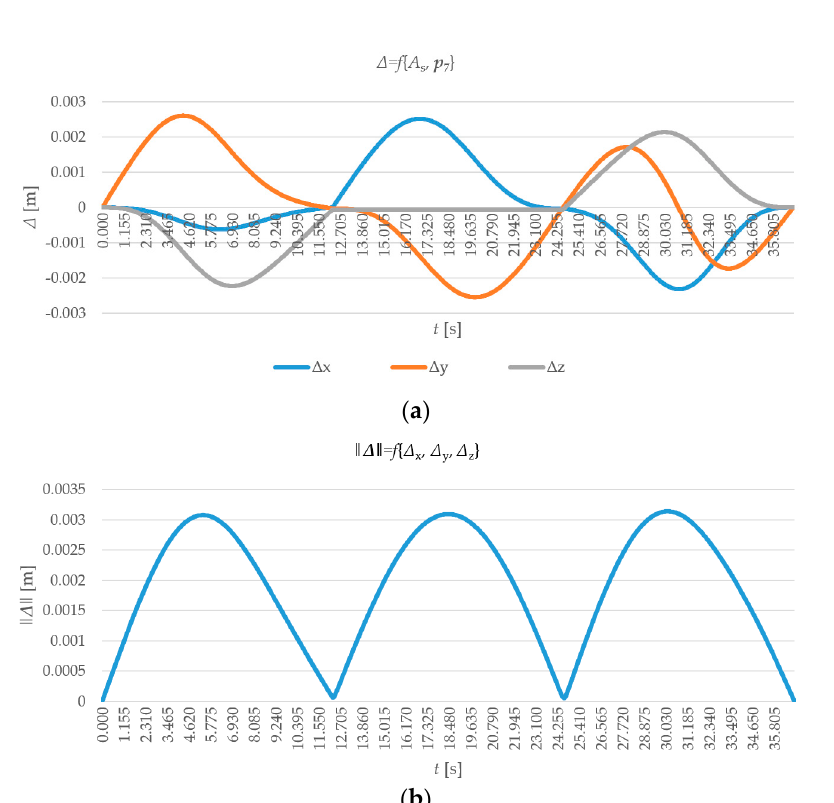
Figure 9. ( a ) The chart showing the difference Δ x , Δ y , Δ z between the real trajectory (composed of the A s { x As , y As , z As } points) and the one calculated (from the components of the position vector effector p 7x , p 7y , p 7z ) in Matlab; ( b ) norm (size) of the vector ‖ Δ ‖ .